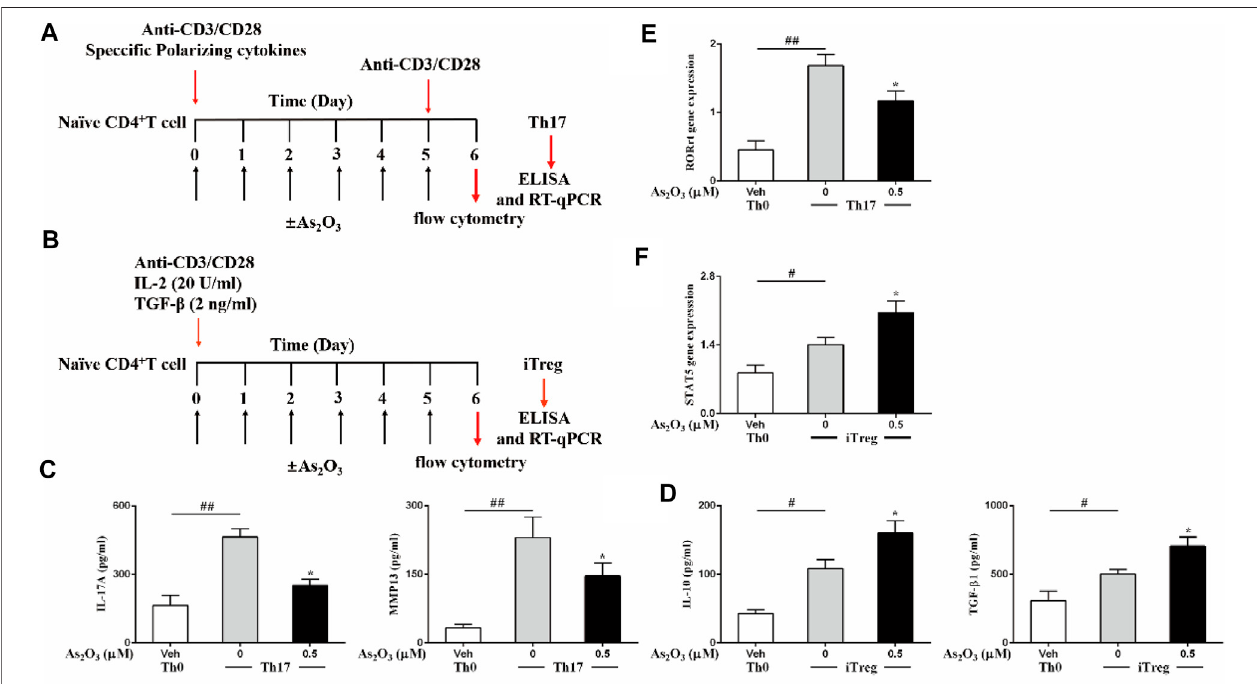
FIGURE 3 | As 2 O 3 affects Treg and Th17 cells differentiation. (A,B) Schematic representative of Th17 and Treg-cell differentiation. (C,D) ELISA of IL-17A and MMP13 in supernatants of Th17 cells polarized, IL-10 and TGF- β release in supernatants of Treg-cell production in the presence or absence of As 2 O 3 (0.5 µM), measuredafter24 hofrestimulationwithanti-CD3/CD28. (E,F) RT-qPCRanalysisoftheexpression ROR γ tforTh17cells, ofSTAT5 inTregcells. Cyclingthreshold(CT) values are normalized to glyceraldehyde-3-phosphate dehydrogenase (GAPDH). Data are represented as means ± SEM of six independent experiments. # p < 0.05, ## p < 0.01 vs. nonpolarized CD4 + T cells; * p < 0.05, ** p < 0.01 vs. Th17 cells nontreated with As 2 O 3 (one-way